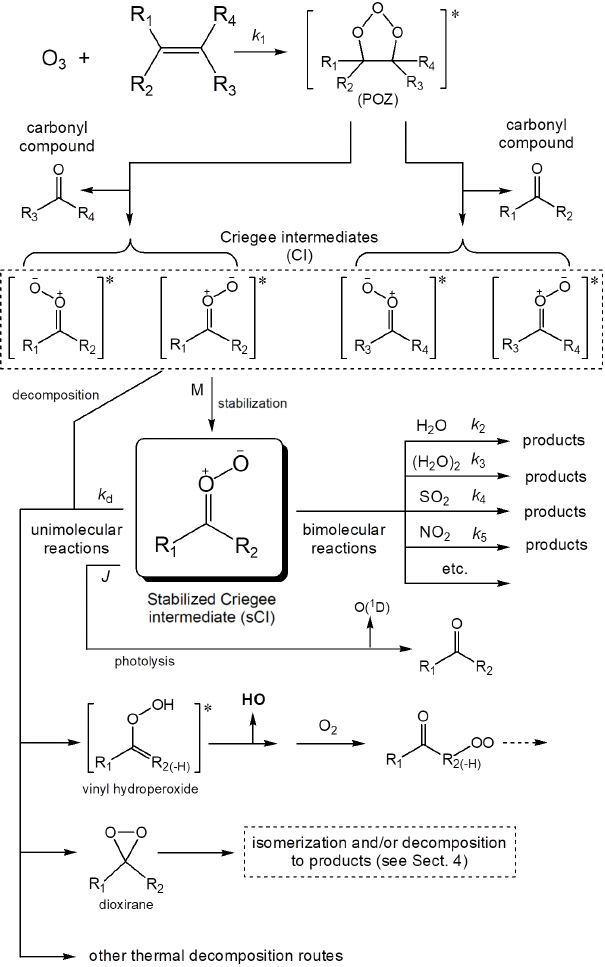
Figure 1. Mechanism of the reaction of ozone with alkenes, show- ing formation of Criegee intermediates (CIs). The general types of reaction available for stabilized Criegee intermediates (sCIs) are also illustrated for one example. The substituents R 1 to R 4 can be either H atoms or organic groups, although the illustrated sCI/CI vinyl hydroperoxide route is unavailable if R 2 = H. Note that in the case of endocyclic C = C bonds in cycloalkenes, the initially formed carbonyl and CI moieties are substituents of the same organic prod-